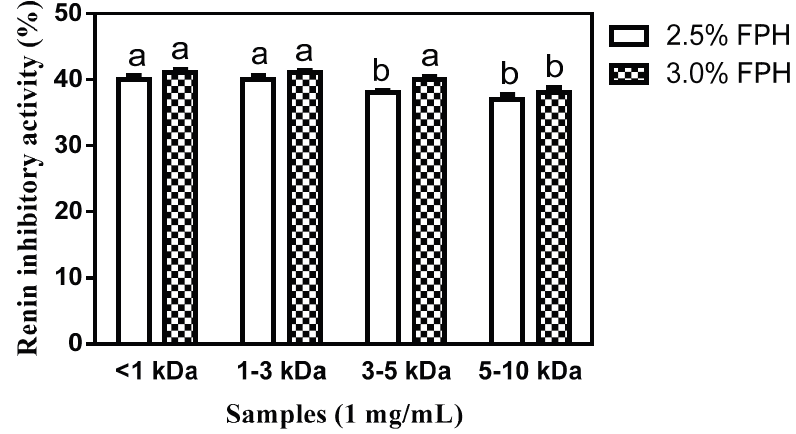
Figure 4. Percentage (mean ± standard error) renin-inhibitory activity of flaxseed protein hydrolysate (FPH) membrane ultrafiltration fractions after hydrolysis of isolated flaxseed proteins with 2.5% or 3.0% thermoase GL-30 and passing the hydrolysates through MWCOs of 1, 3, 5 and 10 kDa. Bars with different letters have mean values that are significantly different ( p <